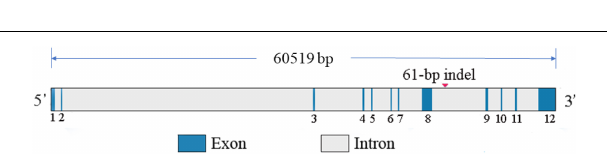
FIGURE 2 | Sequence diagrams of the chicken RIN2 61-bp indel locus.